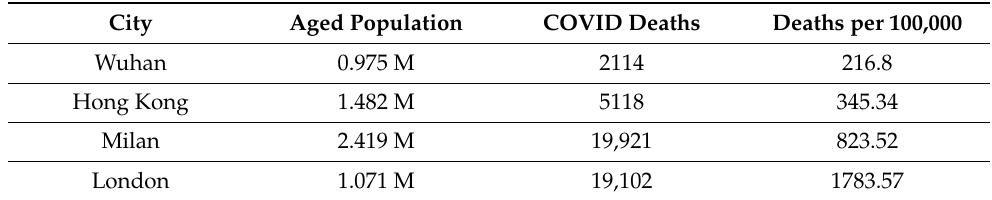
Table 4. COVID-19 deaths and mortality of older